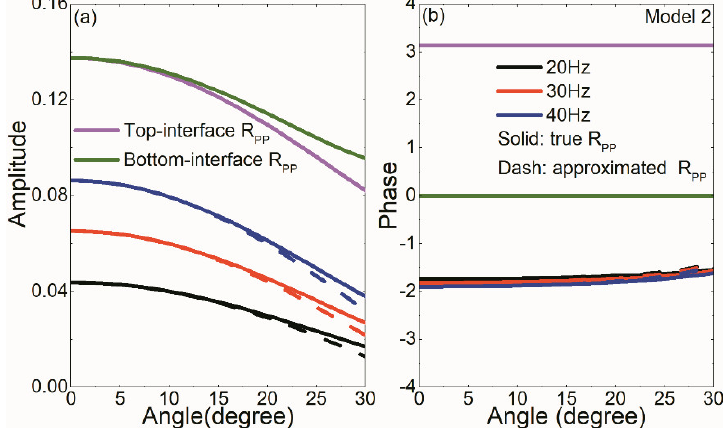
Figure 5. Comparison of Model 2’s R PP calculated by true value and the second-order series approximation, and top-interface and bottom-interface R PP calculated by the Zoeppritz equations, ( a ) amplitude, and ( b ) phase.